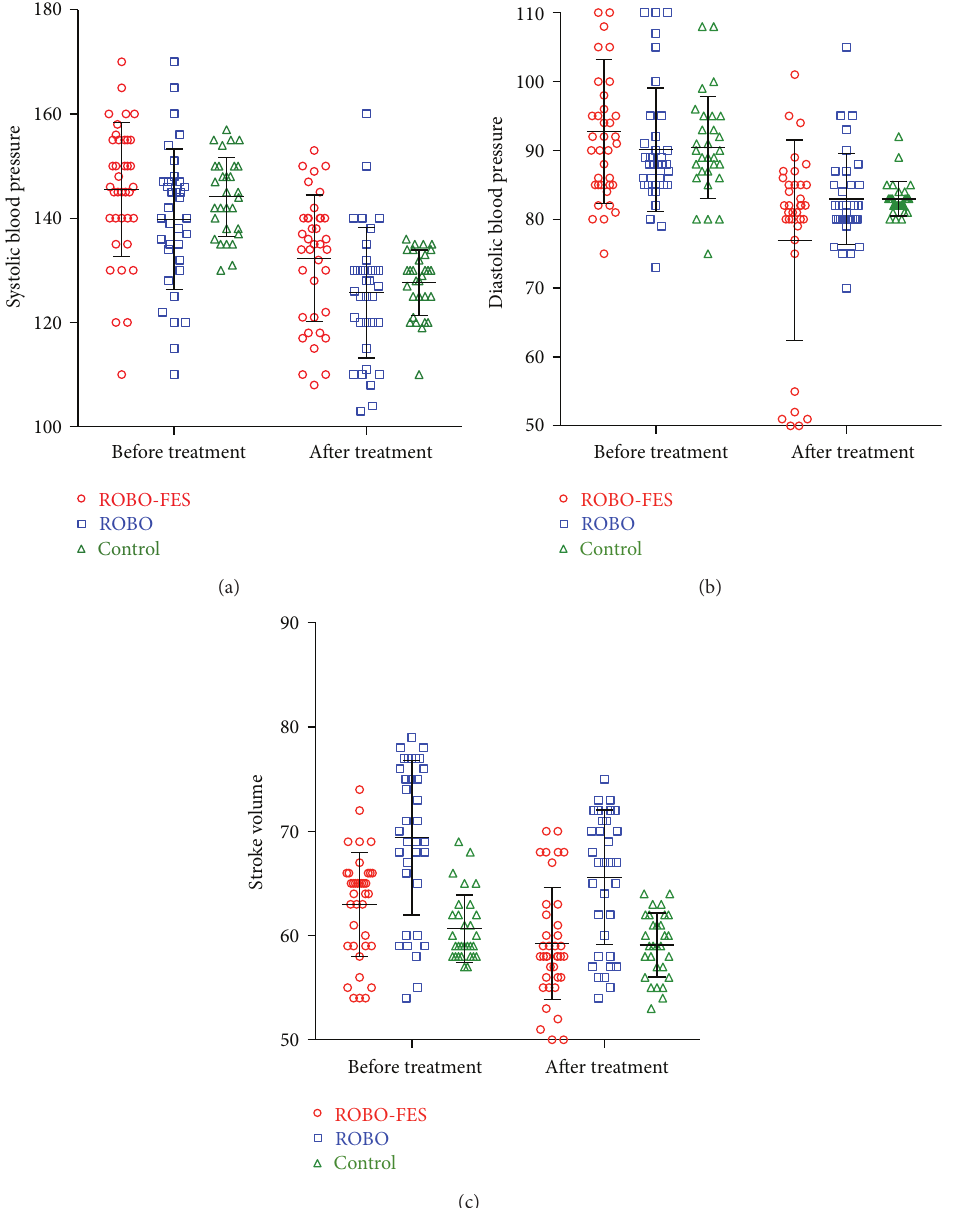
Figure 5: Changes in systemic blood pressure over the course of training. Systemic blood pressure (a, b) and stroke volume (c) similarly